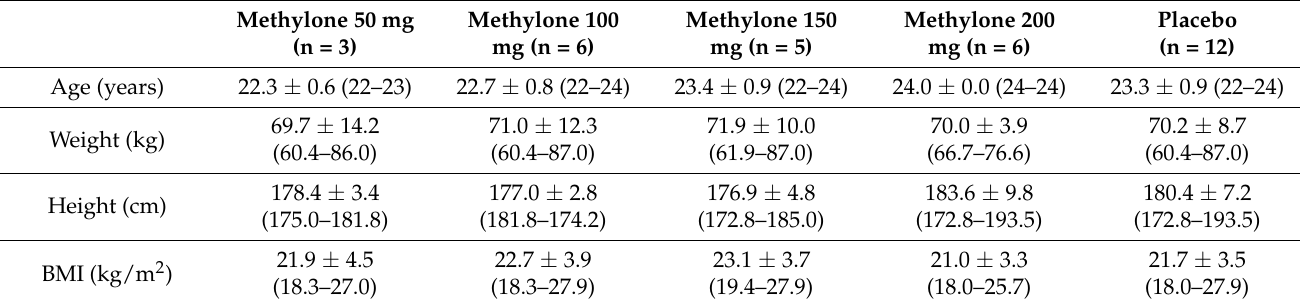
Table 1. Characteristics of the